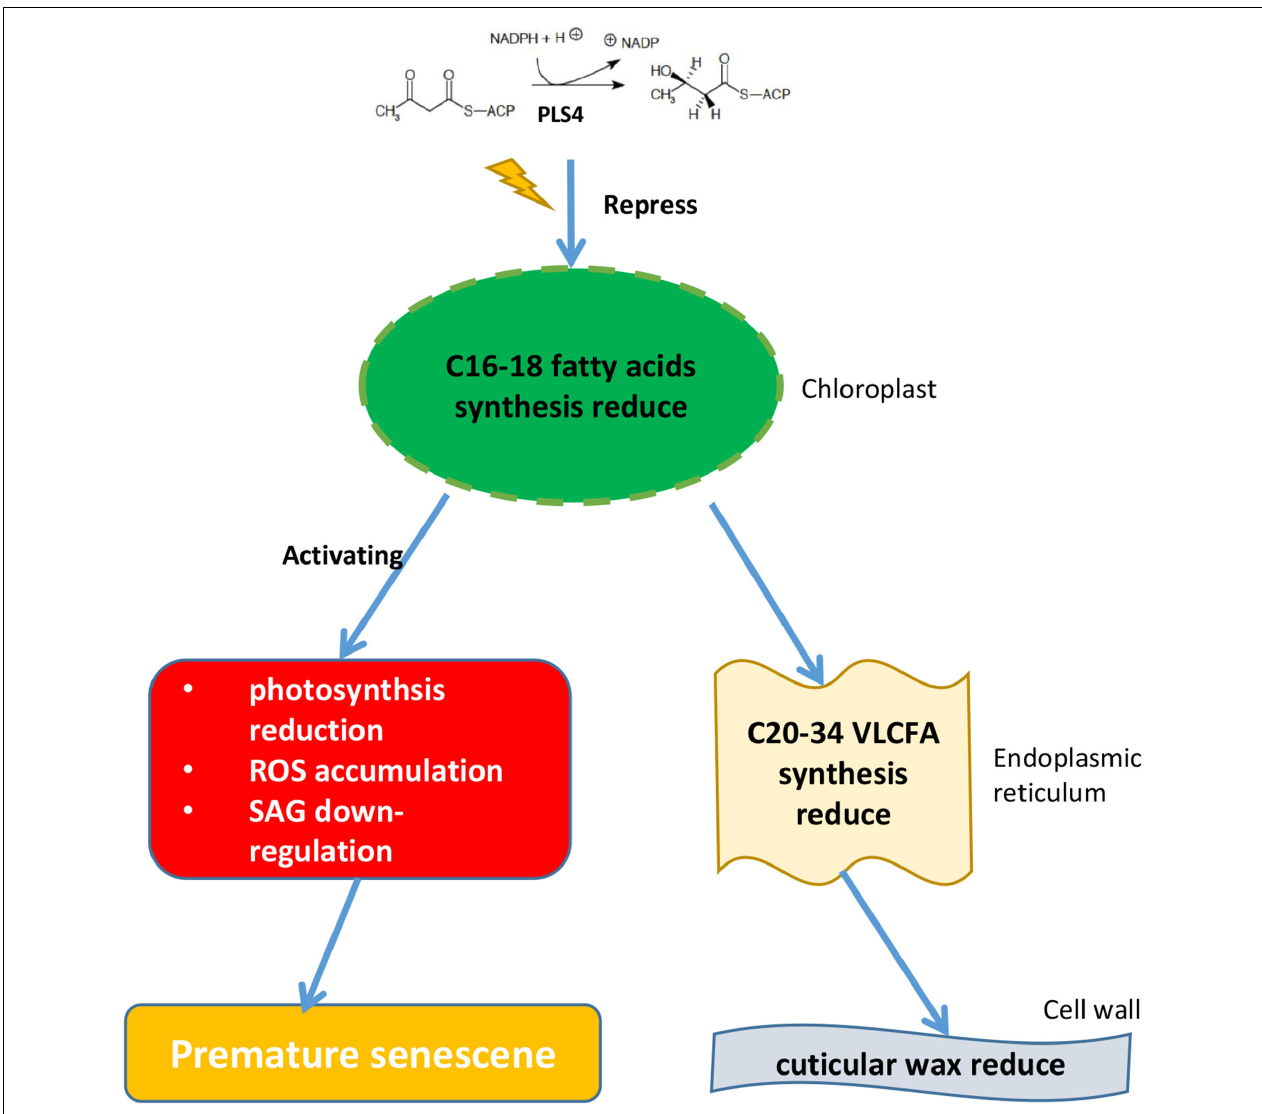
FIGURE 7 | Proposed model for the function of OsPLS4 in cuticular wax formation and leaf senescence. OsPLS4 gene mutation would lead to blocked fatty acid synthesis in chloroplast, which caused the VLCFA synthesis and cuticular wax decrease in pls4 mutant. However, abnormal chloroplast development affected the photosynthetic rate reduction, ROS accumulation and the expression level of the SAGs, ultimately leading to premature leaf senescence in the pls4